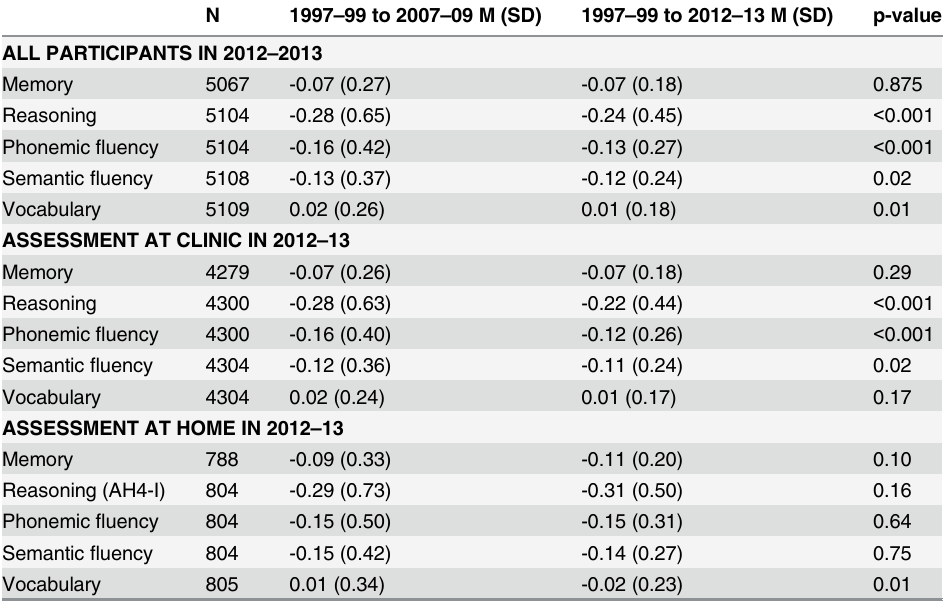
Table 1. Comparison of annual change between 1997 – 99 and 2007 – 09 with that between 1997 – 99 and 2012 –